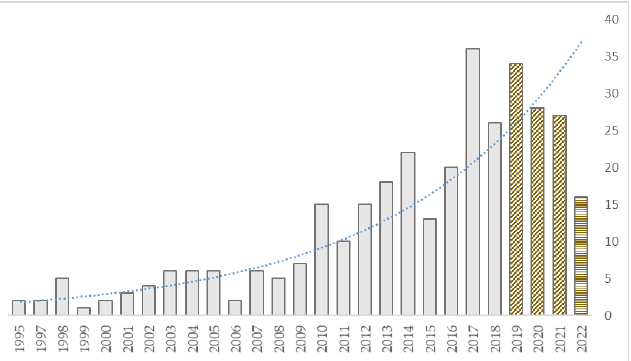
Figure 3. The number of selected studies and overall trend from 1995 to August 2022.